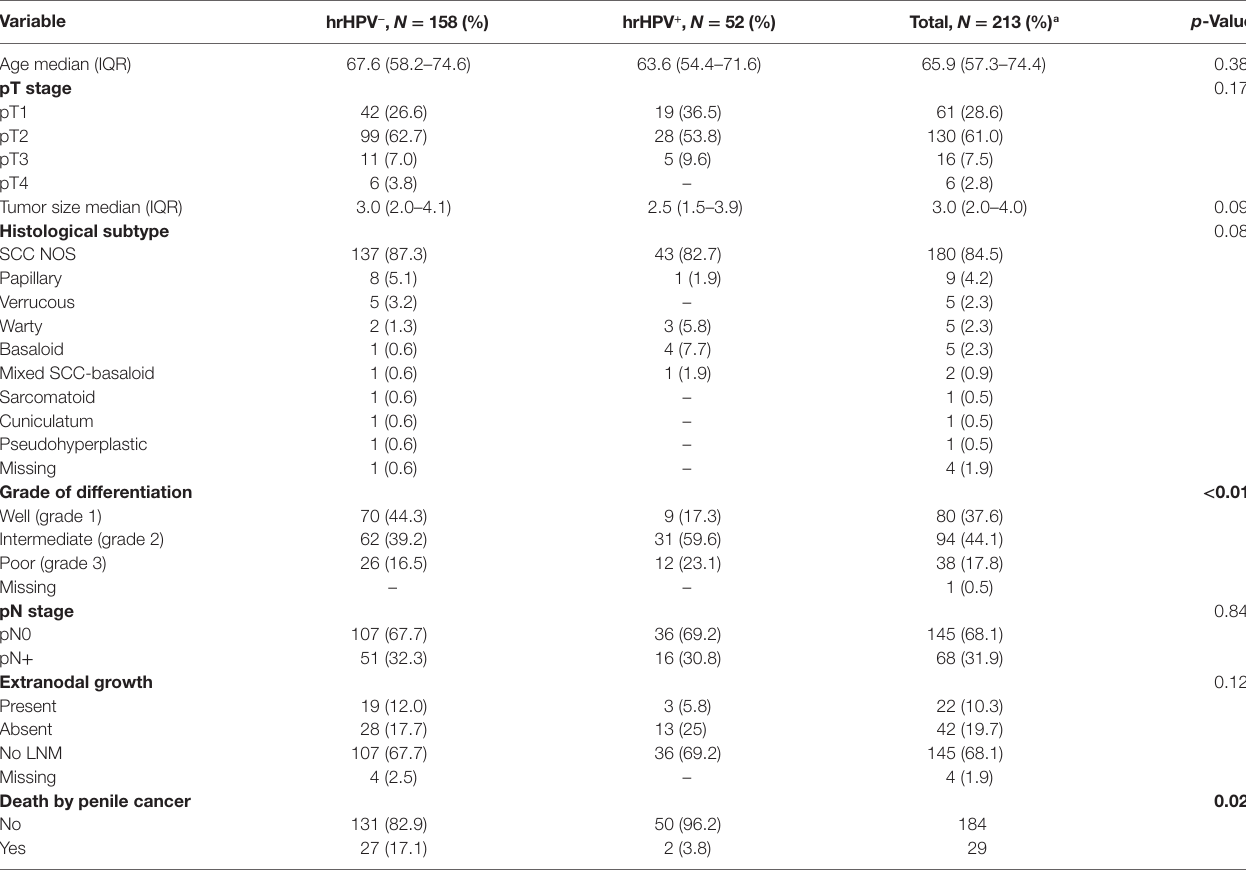
TaBle 1 | Clinicopathological characteristics. Variable